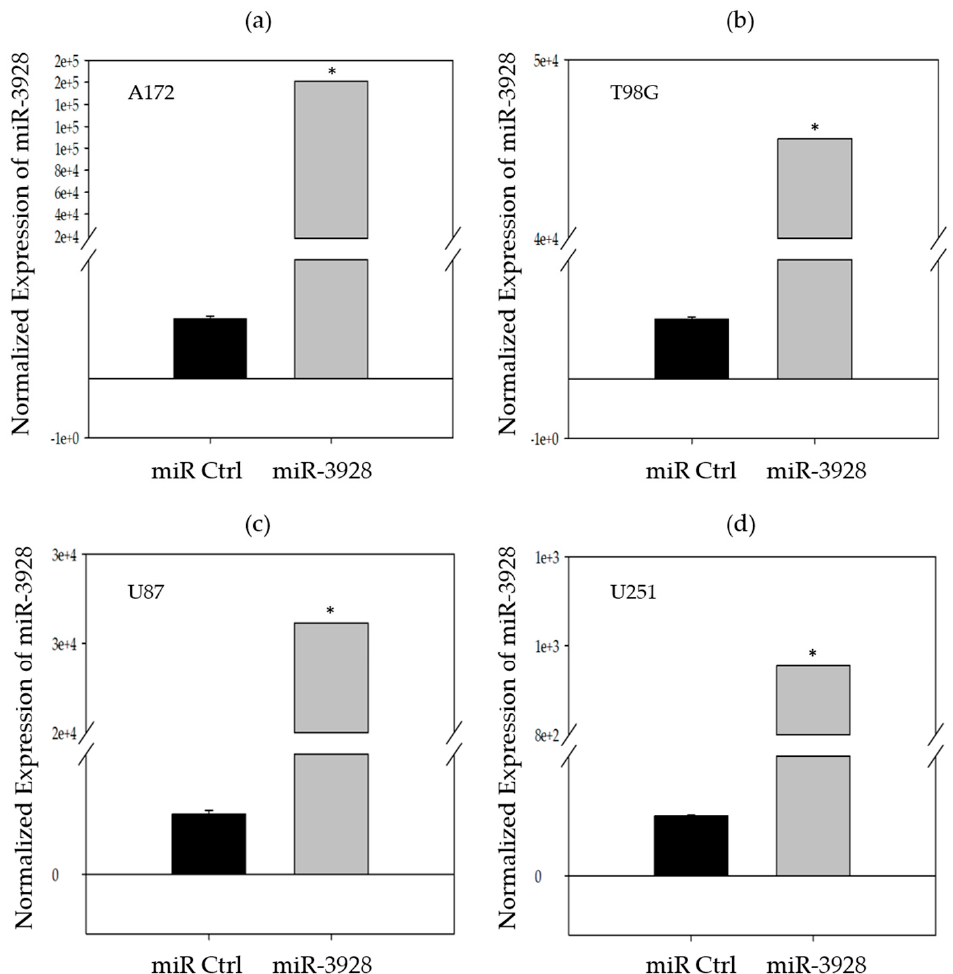
Figure 2. Confirmation of miR-3928 overexpression in GBM cell lines. MiR-3928 levels are measured using RT-qPCR and the values are normalized to the same cell lines transfected with microRNA scrambled control and the housekeeping gene, RNU6B, U6B small nuclear RNA gene. ( a ) Exogenous overexpression of transiently transfected miR-3928 in A172 cells. ( b ) Exogenous overexpression of transiently transfected miR-3928 in T98G cells. ( c ) Exogenous overexpression of transiently transfected miR-3928 in U87 cells. ( d ) Exogenous overexpression of transiently transfected miR-3928 in U251 cells. All RT-qPCR samples are subsequently analyzed on an agarose gel to confirm binding specificity. Student’s t -tests were performed to compare the qPCR cycle numbers. * = p ≤ 0.05.